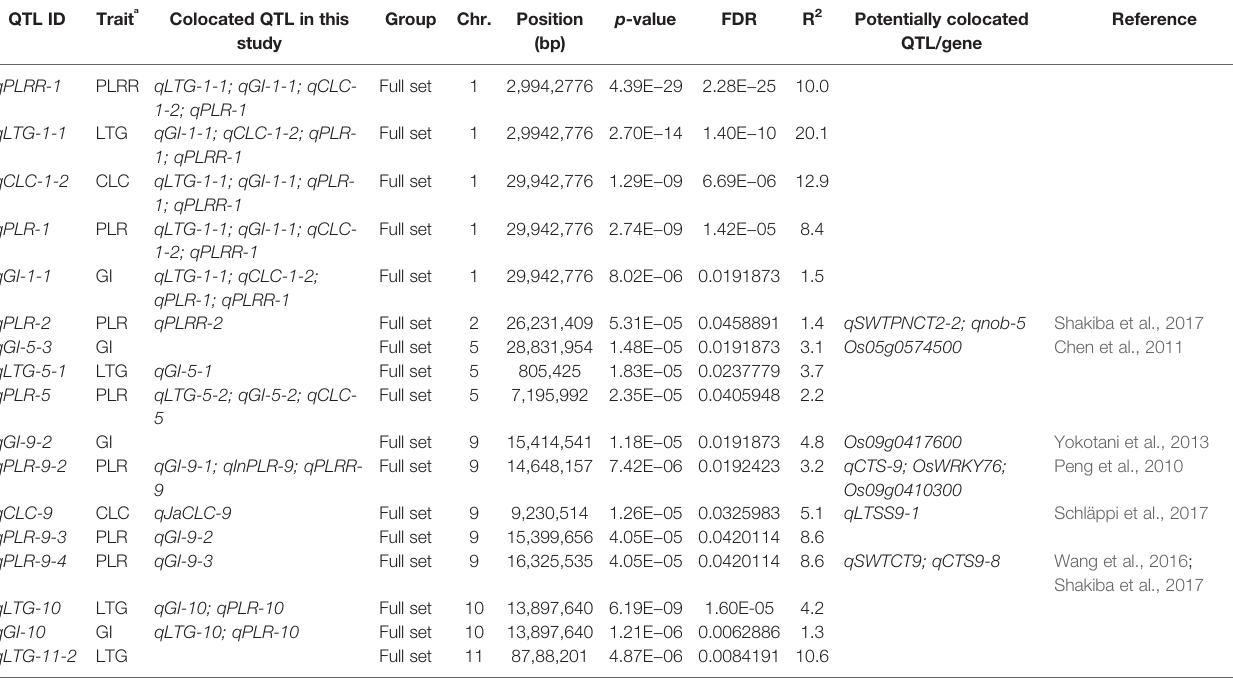
TABLE 4 | QTLs with FDR < 0.05 detected in the whole panel, japonica and indica subsets, and colocalized genes and